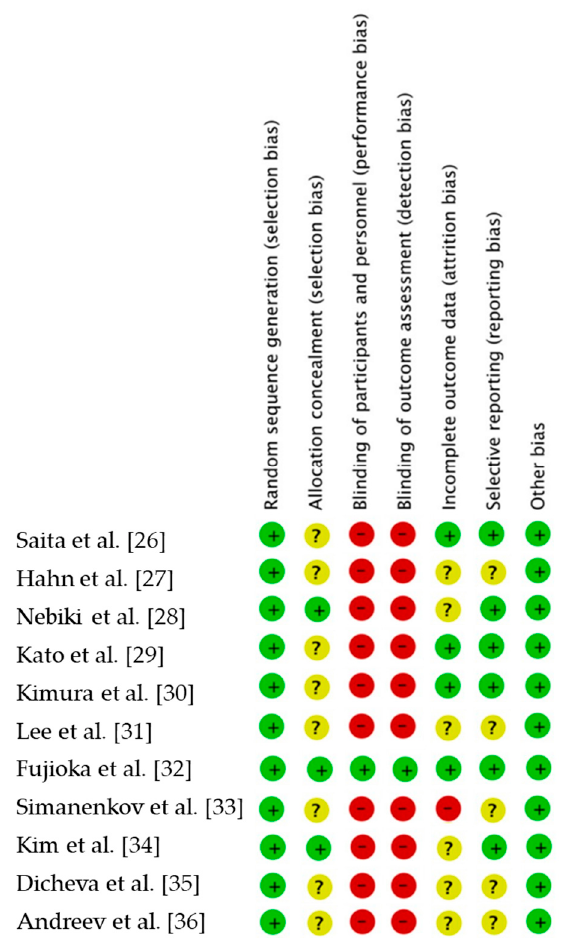
Figure 1. CONSORT chart detailing the study selection strategy.